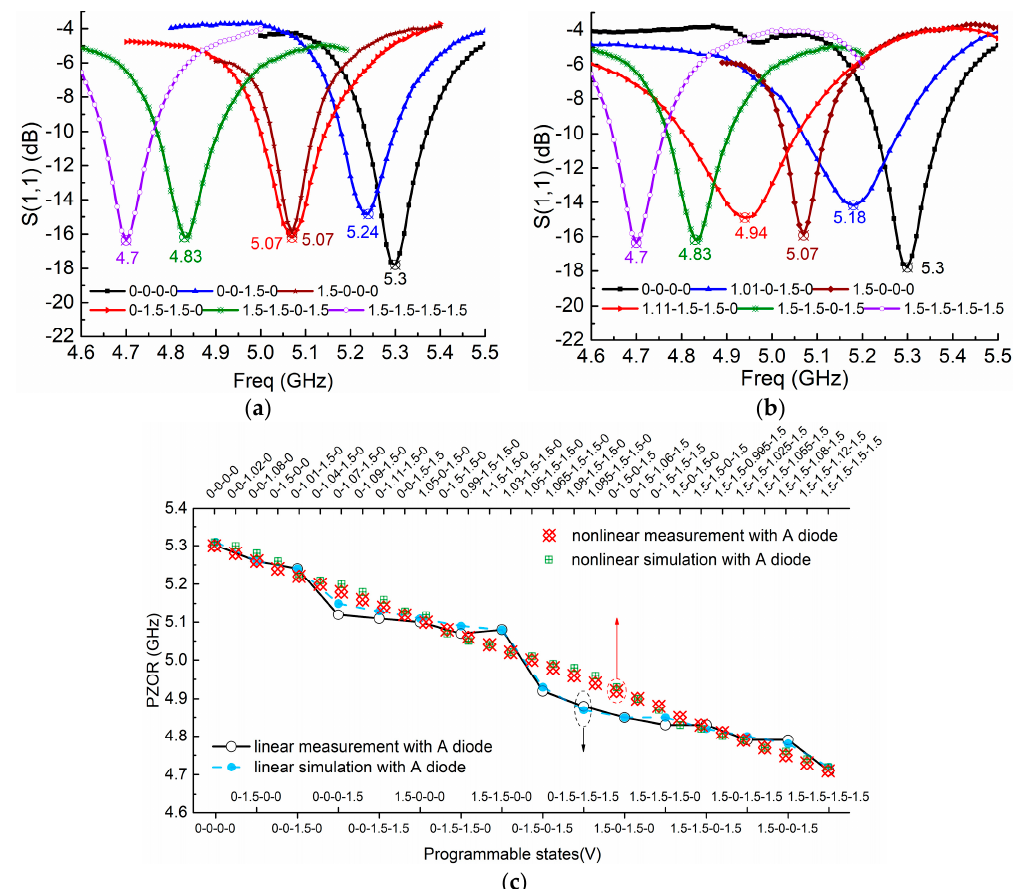
Figure 8. ( a ) Measured ZOR tuning in linear case including states: 0-0-0-0, 0-0-1.5-0, 1.5-0-0-0, 0-1.5-1.5-0, 1.5-1.5-0-1.5, 1.5-1.5-1.5-1.5 and ( b ) in nonlinear case including states: 0-0-0-0, 1.01-0-1.5-0, 1.5-0-0-0, 1.11-1.5-1.5-0, 1.5-1.5-0-1.5, and 1.5-1.5-1.5-1.5; ( c ) ZOR comparisons between linear case of all 16 linear states, and nonlinear case of 30 states.